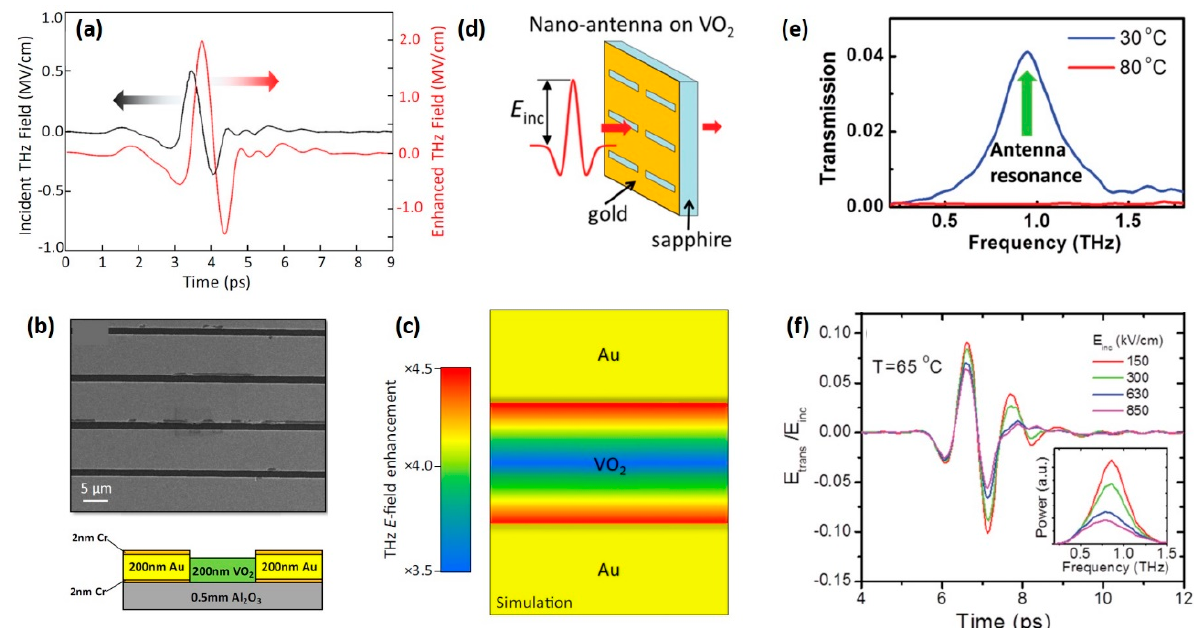
Figure 6. IMT triggered by intense Terahertz pulse. ( a ) Simulated enhanced THz field (red) in the metamaterial gaps using experimental data (black) as the input. ( b ) SEM image of the grating pattern showing wider Au lines (8.5 μ m) and narrower (1.5 μ m) gaps exposing the VO 2 film (dark contrast). The cross-sectional profile of the structure is shown below. ( c ) THz field enhancement as a function of position within the 1.5 μ m gap, showing an average field enhancement of ×4. Reproduced from [68], with permission from American Physical Society 2018. ( d ) Gold nanoantenna array (antenna width, 200 nm; length, 60 µ m) is patterned on a 100 nm-thick VO 2 thin film deposited on sapphire substrate. ( e ) A transmission spectrum showing antenna resonance at 0.9 THz with insulating VO 2 at room temperature (blue line), whereas the resonant transmission disappears with metallic VO 2 at high temperature (red line). ( f ) Response of the device under different THz field strengths of 150 kV/cm, 300 kV/cm, 630 kV/cm and 850 kV/cm at 65 °C. The corresponding frequency spectra are shown in the insets. Reproduced from [69], with permission from American Chemical Society 2015.